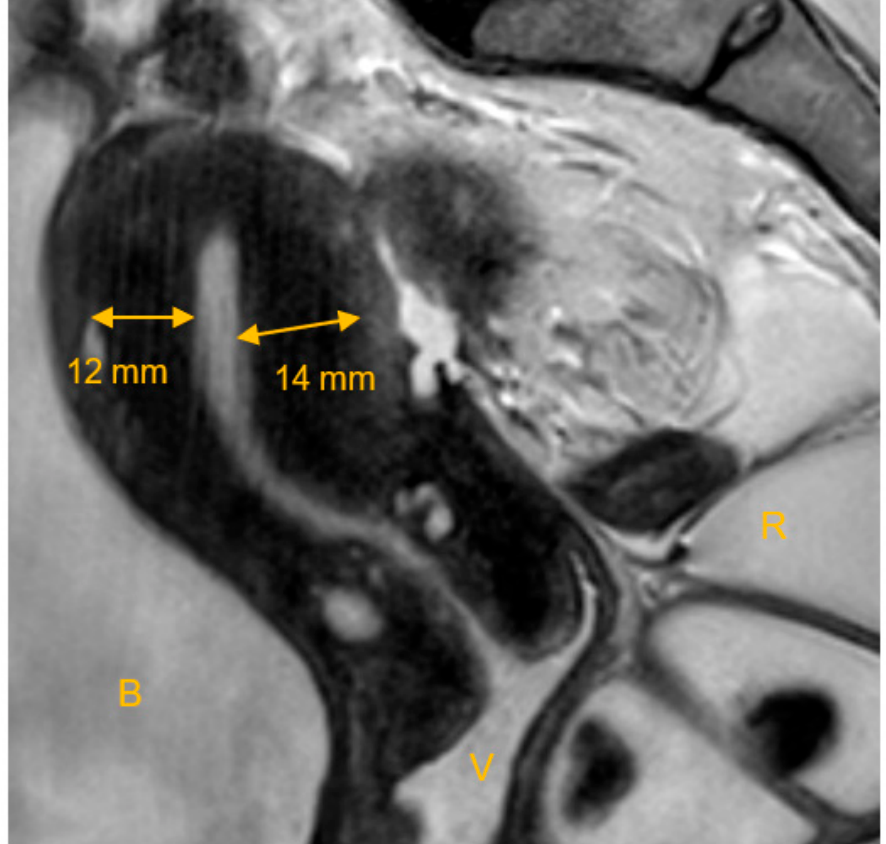
Figure 2. MRI characteristics of the uterine junctional zone. T2-weighted MRI in the sagittal plane, showing the widened junctional zone marked with arrows. B: bladder, V: vagina filled with ultra- sound gel, R: rectum filled with ultrasound gel. Image acquisition on 3T, Ingenia Philips Healthcare, with a T2 TSE sequence.